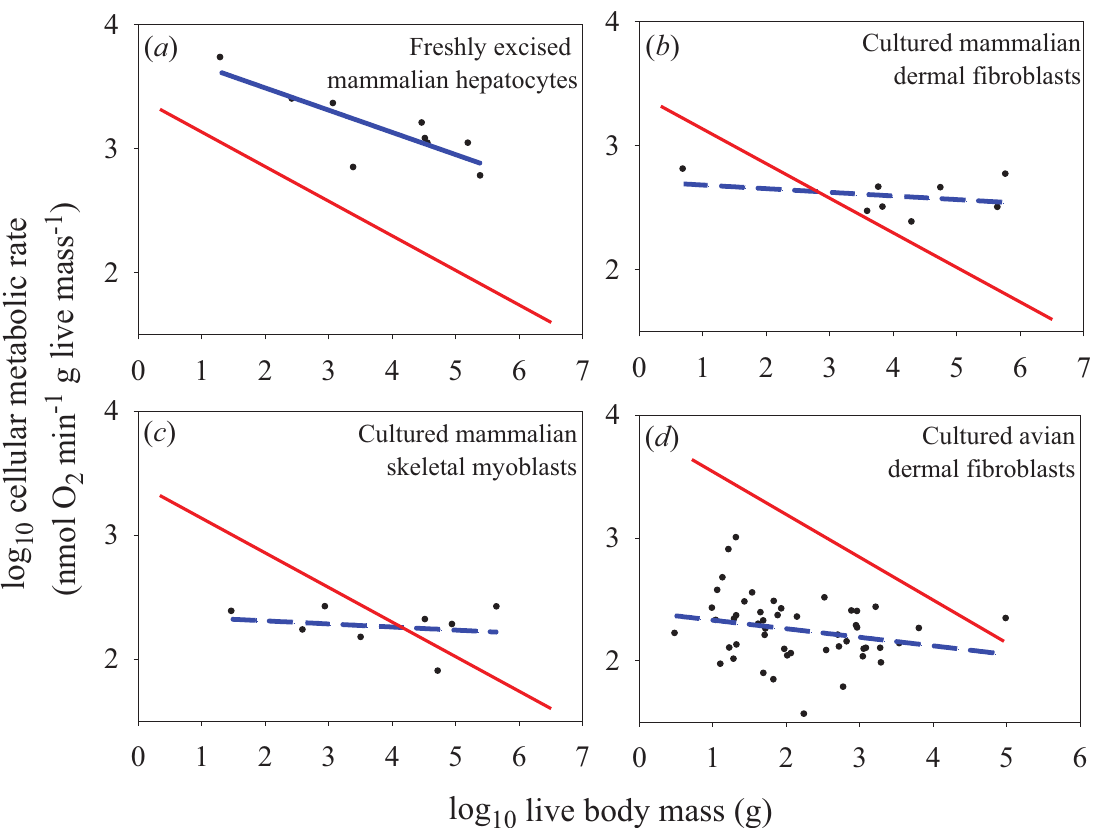
Figure 2. Scaling of log mass-specific cellular metabolic rates in vitro (for cultured or freshly excised cells: blue lines) and in vivo (for cells intact in whole organisms: red lines) with log body mass. The in vivo scaling lines are based on the mass-specific scaling of basal metabolic rate in mammals ( a , b , c : Y = 2.60(X) −0 .279 ; r 2 = 0.959; p < 0.0001; N = 639; data from [19]) and birds ( d : 7.71(X) − 0.348 ; r 2 = 0.942; p < 0.0001; N = 533; data from [20]). Note that the high r 2 values (for log-log regressions) indicate that these relationships are very strong (only 4.1% and 5.8% of the variation in basal metabolic rate is not explained by body mass in mammals and birds, respectively), and thus very useful as reference lines for